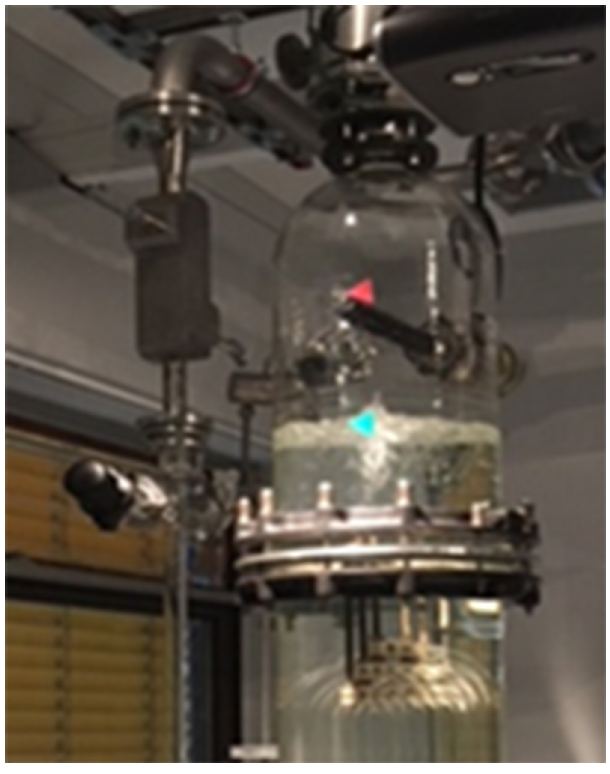
Fig. 6. sCO 2 -compact heat exchanger attached to glass model.